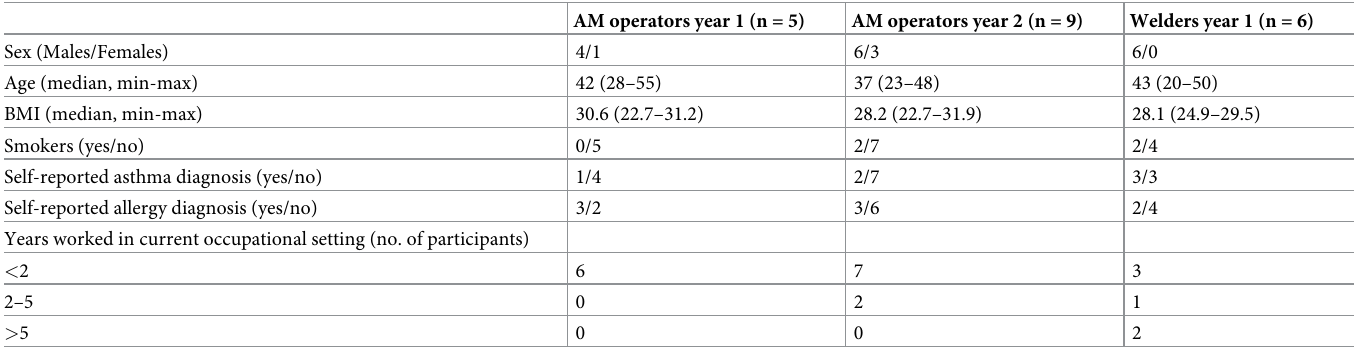
Table 1. Participant